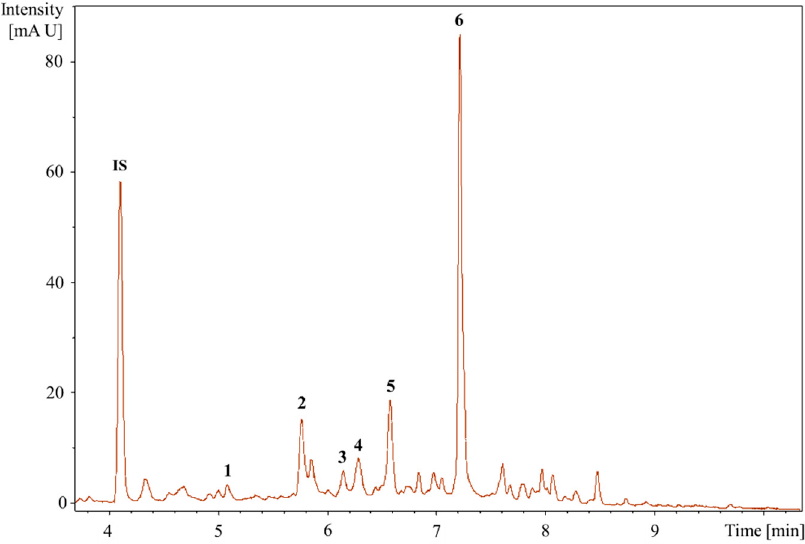
Figure 4. UV chromatogram of Mystry HPLC sub-fraction at 280 nm. 1–6: annotated metabolites, 1: quercetin-3- O -glucoside, 2: a catechin derivative, 3: eriodictyol-7- O -glucoside, 4: quercitrin, 5: azelaic acid, 6: glansreginin A, and IS: internal standard.